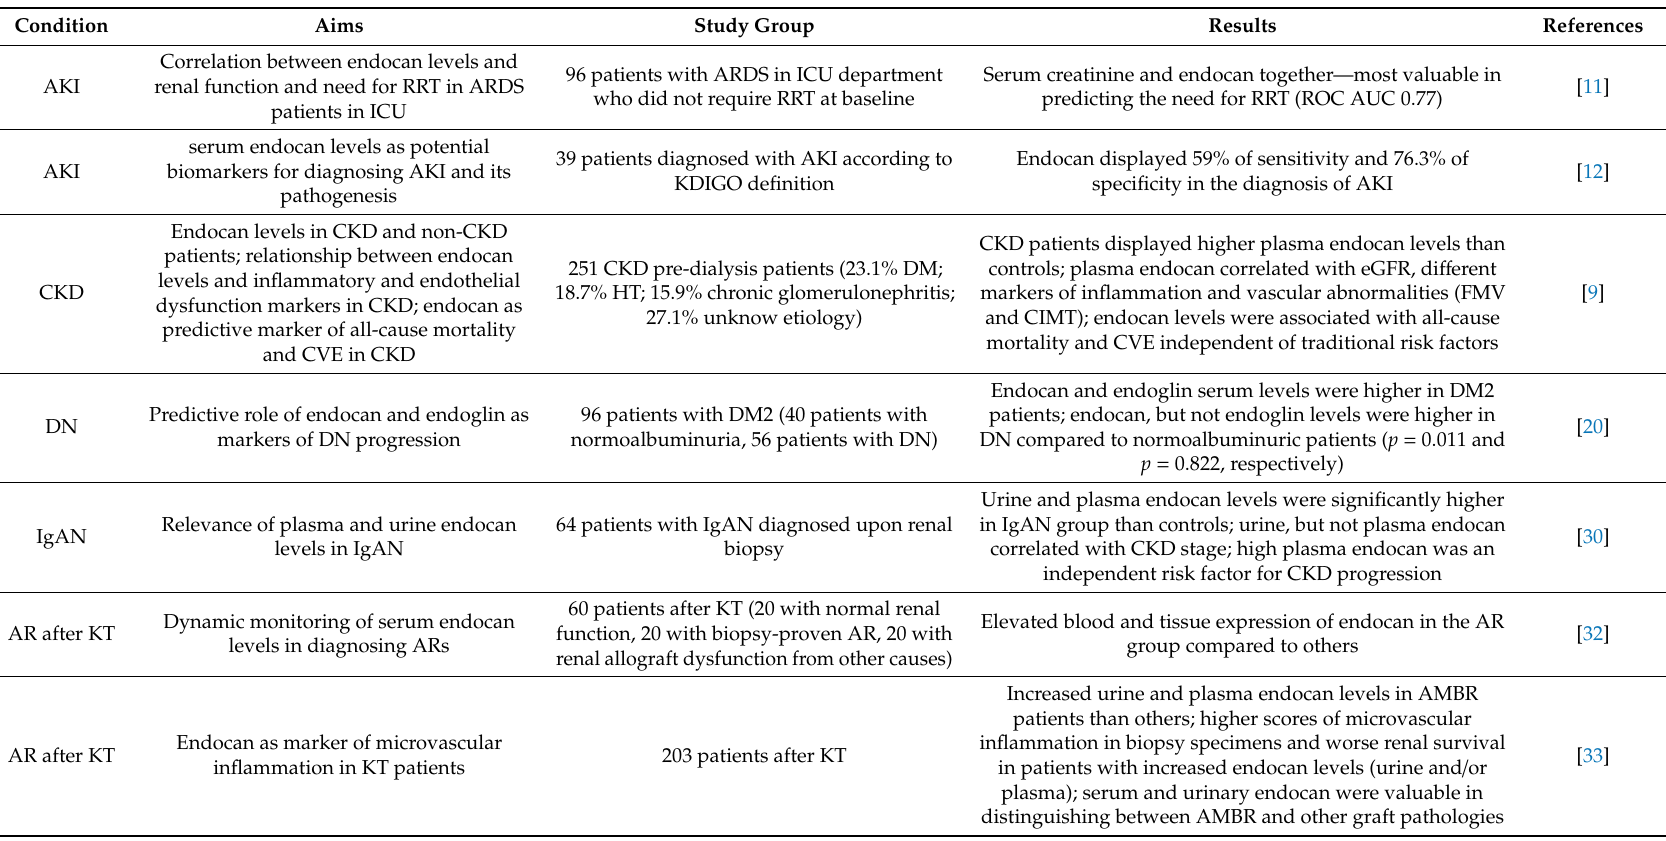
Table A1. Most valuable studies examining the role of endocan in various kidney